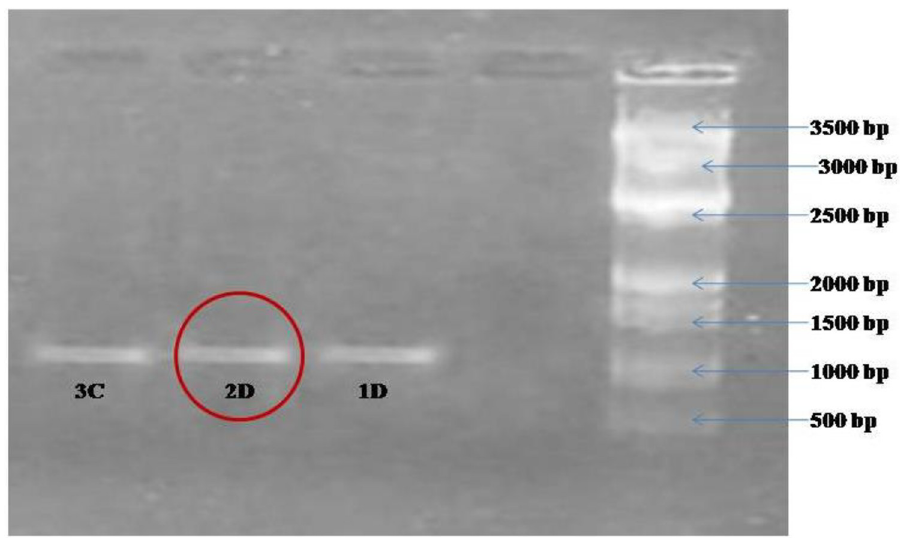
Fig 3. Amplification of Laccase gene from bacterial isolate